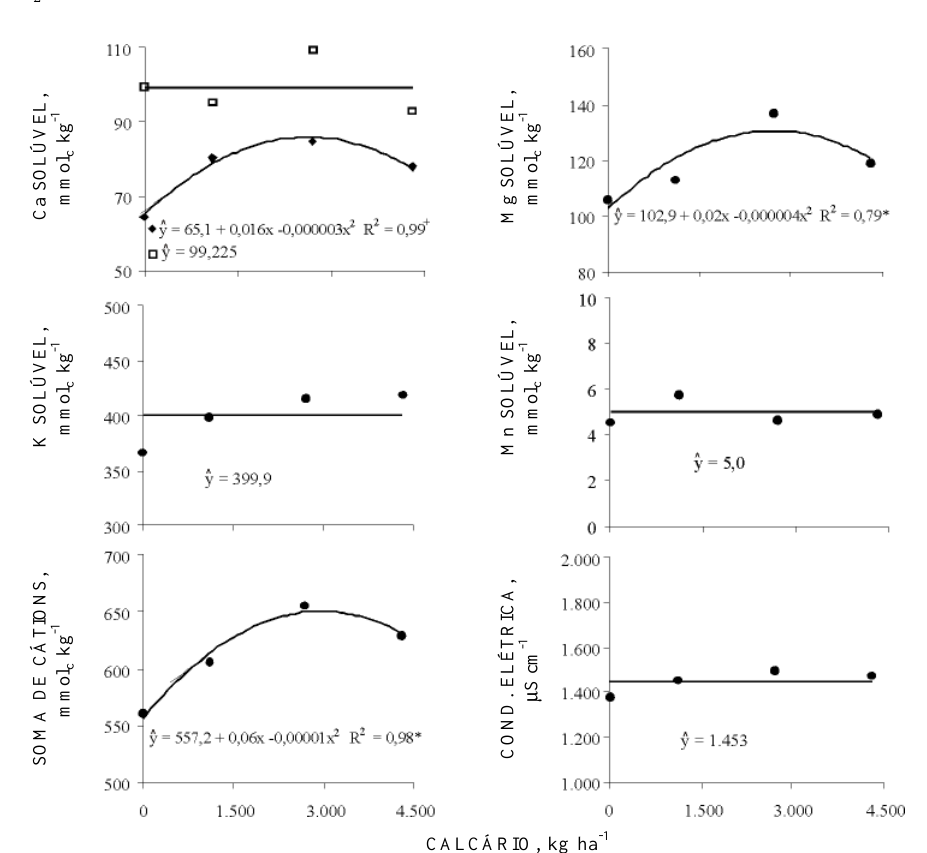
Figura 2. Teores de cátions solúveis nos resíduos vegetais em plantas de aveia-preta (2003) na época do florescimento e condutividade elétrica do extrato, considerando a aplicação de calcário em superfície. ( ) média dos tratamentos com e sem aplicação de gesso, ( ) sem gesso e ( ) com gesso. + , * e ** significativos a 10, 5 e 1 % pelo teste